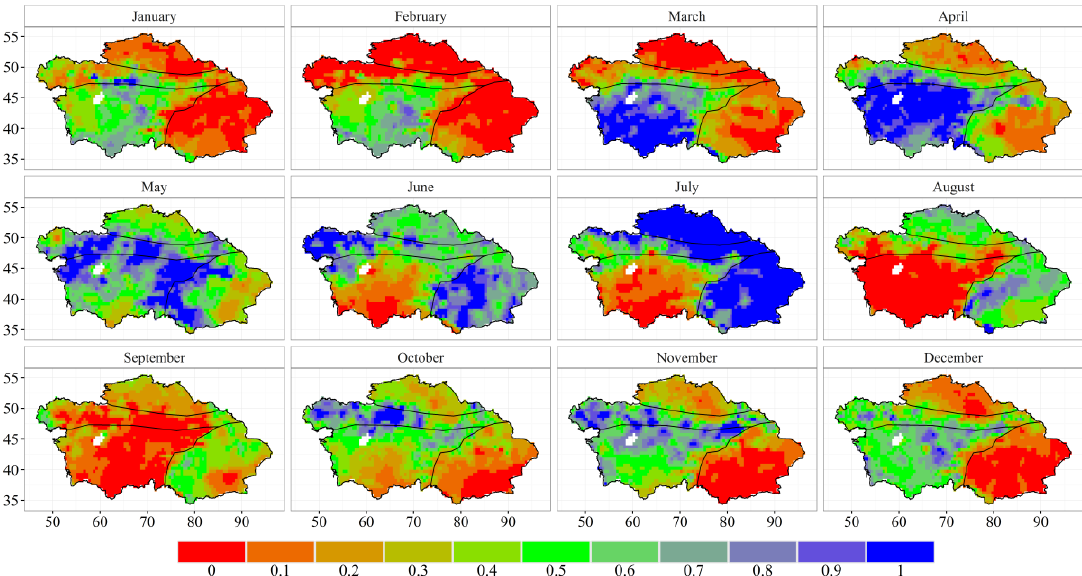
Figure 4. Spatial distribution of monthly precipitation in Central Asia based on the GPCC dataset. The twelve monthly precipitation values in each pixel were transformed into 0-1, and the minimum value was set as 0 while maximum was set as 1.